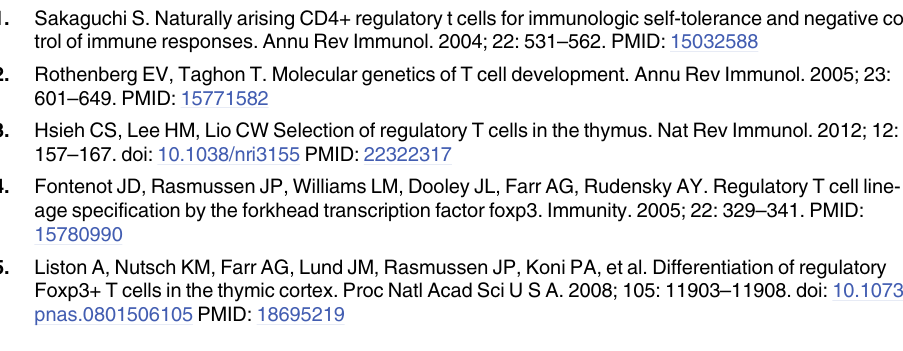
S1 Fig. Identification of I-E к antigen positive mice and expression of the transgenic TCR on CD4SP FOXP3 + cells. (A) Representative PCR from digested tail tissue from TEa-Tcf7 +/+ and TEa-Tcf7 -/- mice. The cognate antigen (Ag) recognized by the TEa T cells is a peptide, called E α , derived from the I-E molecule. The I-E gene in C57BL/6 mice contains an approxi- mately 600bp deletion that encompasses this region and also prevents the generation of a pro- tein product. PCR primers were designed to detect the presence (330bp fragment, Ag-, left lane) or absence of this deletion (957bp fragment, Ag+, right lane). (B) Representative plots showing I-E к antigen expression in splenic CD19 + B cells. (C) Quantification of ratio of TEa-Tcf7 -/- mice in the presence or absence of Ag as depicted in Fig 2G (n = 8). Each dot repre- sents one individual animal and mean is shown for all quantified data. Numbers show percent- ages of cells within the indicated box. (cid:1) P < 0.05, (cid:1)(cid:1) P < 0.01 (unpaired t test) S1 Table. Antibody and Primer